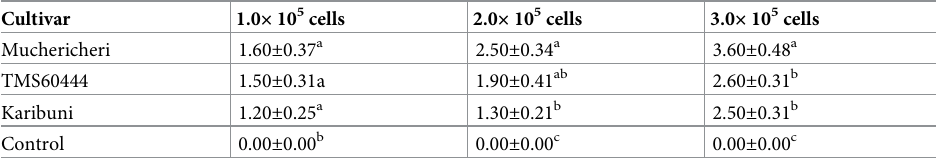
Protoplast cells were cultured on liquid media at varying cell densities. Induction efficiency was calculated as the number of minicalli per cell density Means ( ± SE) followed by different letters in each column are significantly different (P � 0.05) using Fishers